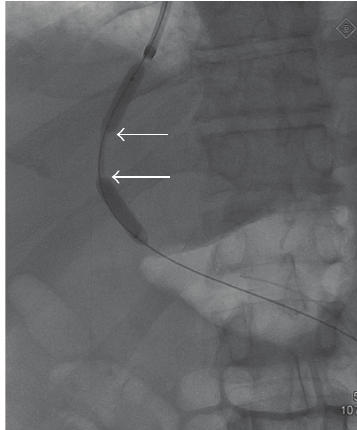
Figure 2: Tract dilatation using a 10mm angioplasty balloon catheter. The narrowed part of the balloon is in the intraparenchy- mal part of the tract (arrows).